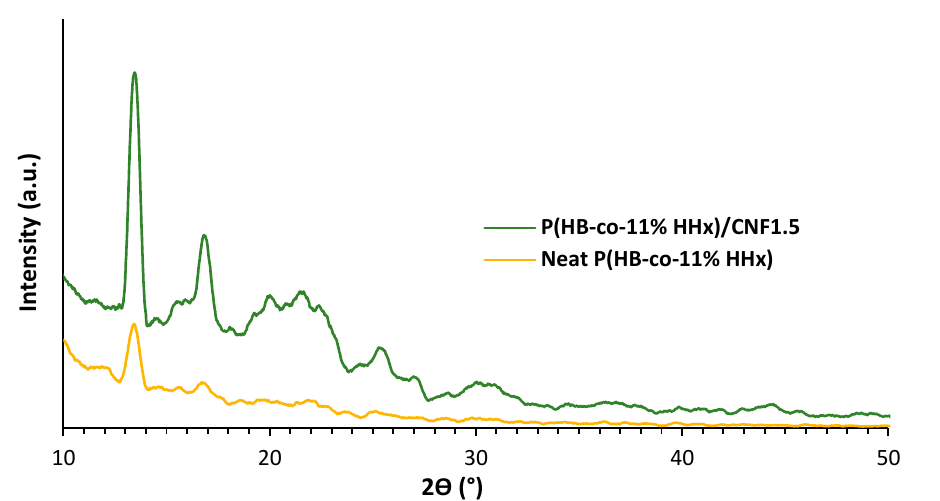
Figure 6. XRD patterns of neat P(HB- co -11% HHx) and optimized P(HB- co -11% HHx)/CNF1.5 bionanocomposites. Table 8. Crystallinity index (CI) of neat P(HB- co -11% HHx) and P(HB- co -11% HHx)/CNF bionanocomposites.